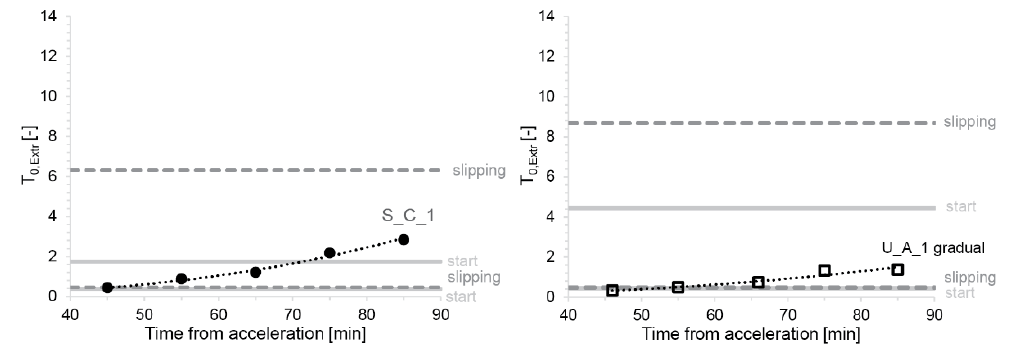
Figure 16. Comparison of measured extrusion yield stress shown with full circles for ‘S_C_1’ material ( left ) and with empty squares for ‘U_A_1 gradual’ material ( right ), along with the operation window between SDC and SDC with a formwork for thin folded structures (continuous horizontal lines 2 SDC + 1 indicate the start-up and dashed the slipping).